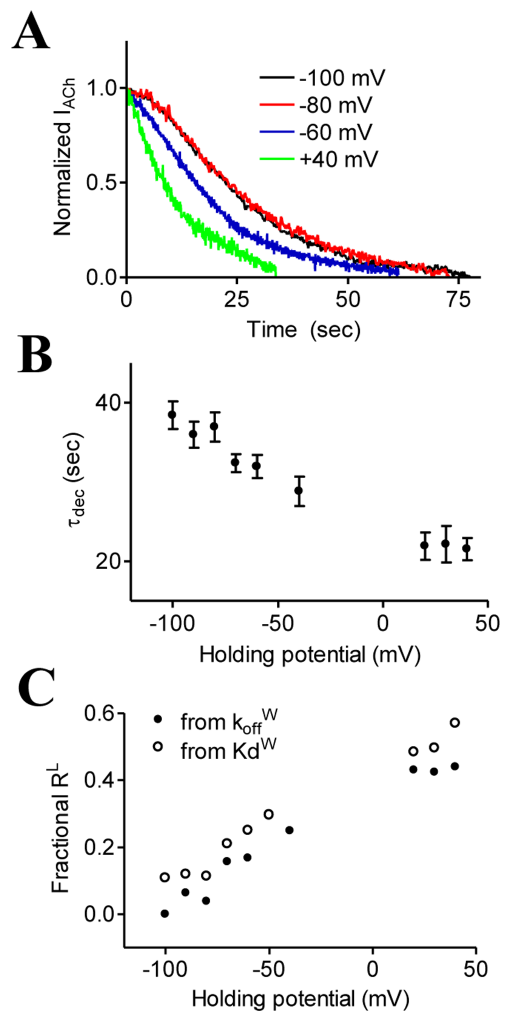
Figure 3. Voltage sensitivity of t dec . (A) The decline of the current evoked by ACh at different holding potentials following washout (beginning at time 0) with agonist free solution. (B) Average 6 SEM of t dec at different holding potentials from 8 to 18 oocytes for each holding potential. (C) The dependency of R L in membrane potential, from experimental data taken from [6] (empty symbols) and from the data shown at (B) (filled